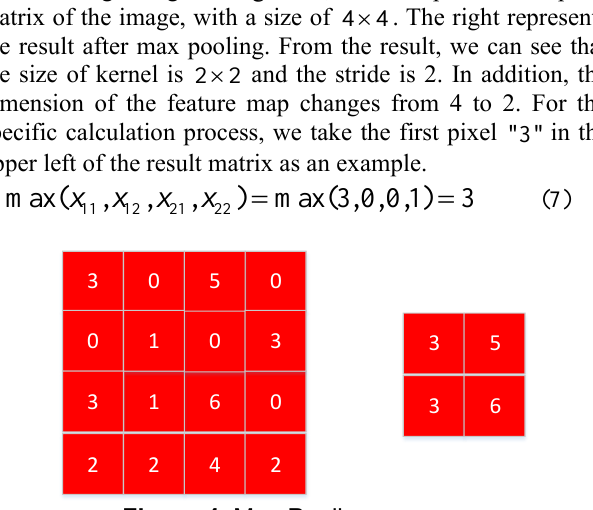
Figure 4. Max Pooling